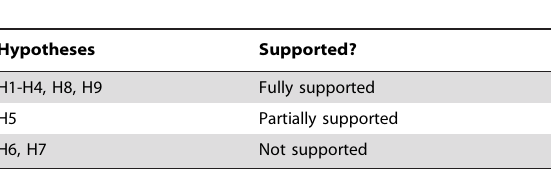
Table 4. A summary of hypotheses testing